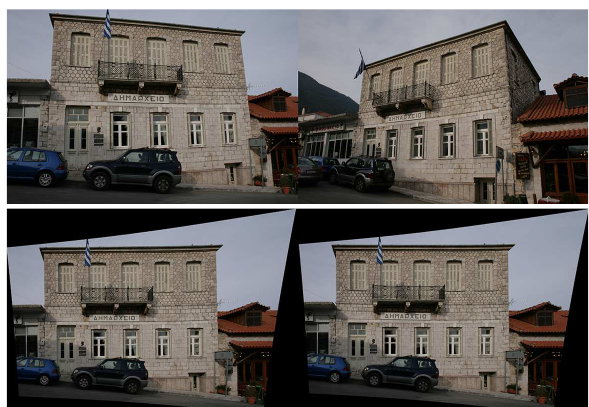
Figure 8. Rectified and rotated left image of the above pair (image axes convergence of 44º).